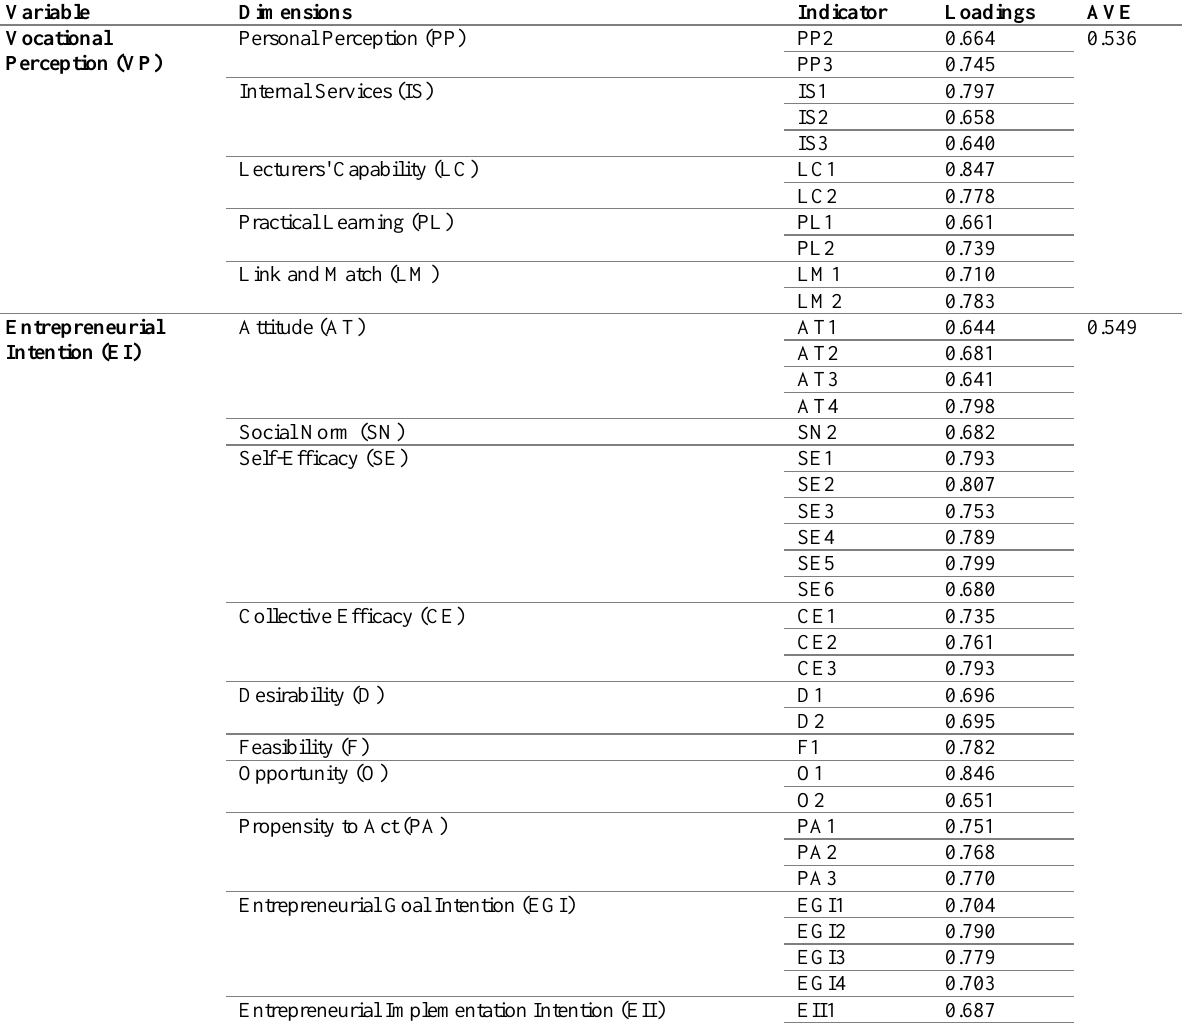
Table 2: Convergent Validity Test